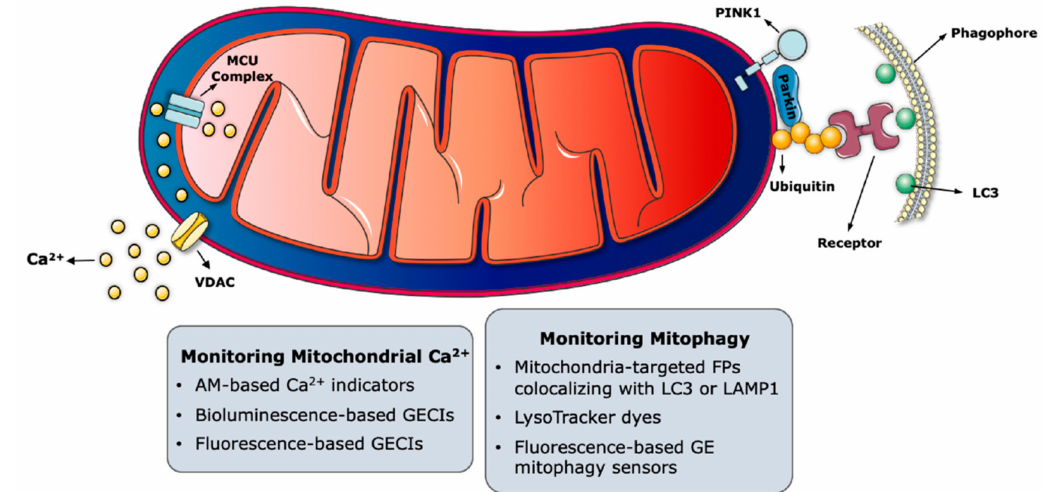
Figure 1. Probes to monitor mitochondrial Ca 2 + signalling and mitophagy. The major molecular players regulating these functions are symbolized within mitochondria. Key imaging-based approaches are listed in the grey boxes in proximity to the corresponding mitochondrial function. MCU complex, mitochondrial Ca 2 + uniporter complex; VDAC, voltage-dependent anion-selective channel proteins; PINK1, phosphataseandtensionhomologue(PTEN)-inducedputativekinase1; Parkin, E3ligasePARK2; LC3, microtubule-associated protein 1 light chain 3; LAMP1, the lysosomal-associated membrane protein 1; AM, acetoxymethyl ester; GECIs, genetically-encoded Ca 2 + indicators; FPs, fluorescent proteins; GE, genetically-encoded. The figure was generated with elements provided in the Servier Medical Art depository (https: // smart.servier.com / ) and are licensed under a Creative Commons Attribution 3.0 Unported License (CC BY